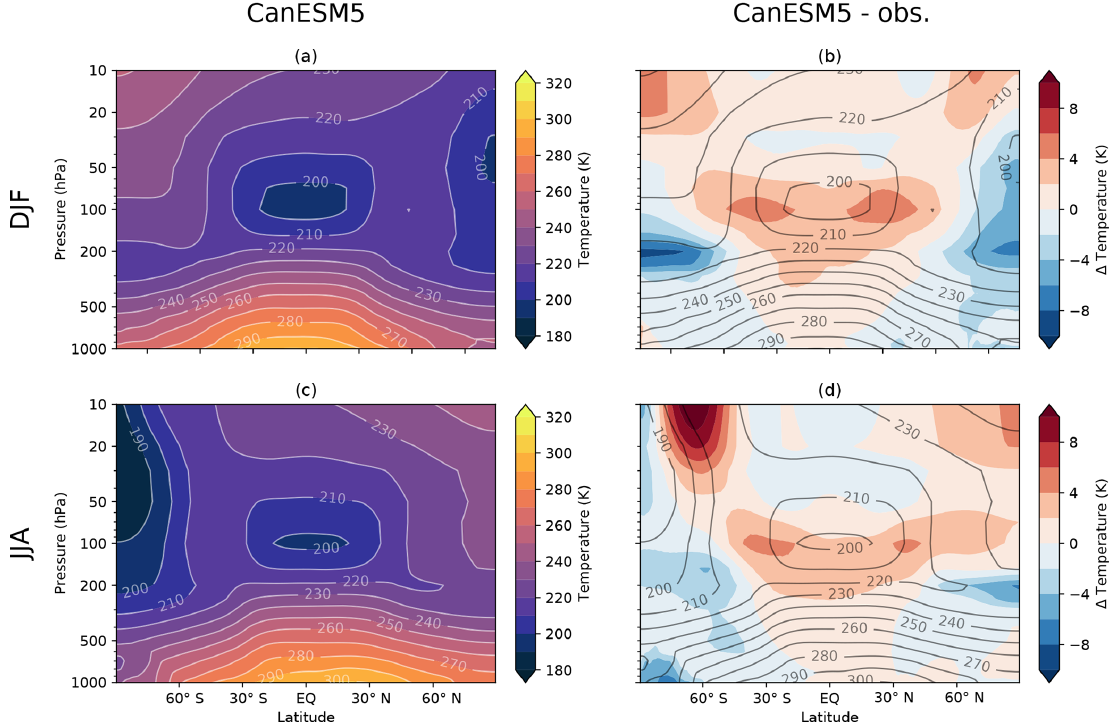
Figure 9. Zonal-mean temperature in CanESM5 (a, c) and bias relative to ERA5 (b, d) over 1981–2010 for the DJF (a, b) and JJA (c, d) seasons.